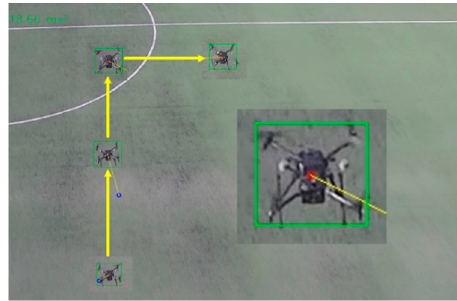
Figure 12. The experiment of tracking UAV.